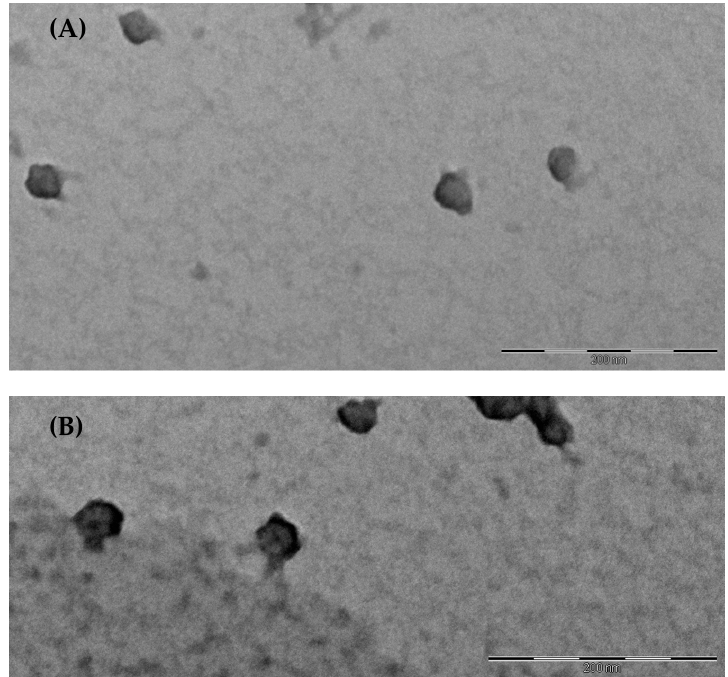
Figure 3. ( A ) Transmission electron microscope (TEM) image of SLM-loaded polymeric nanomicelles (SLM-PNM). Scale bar 200 nm; ( B ) TEM image of SLM-loaded mixed nanomicelles (SLM-MNM). Scale bar 200 nm.